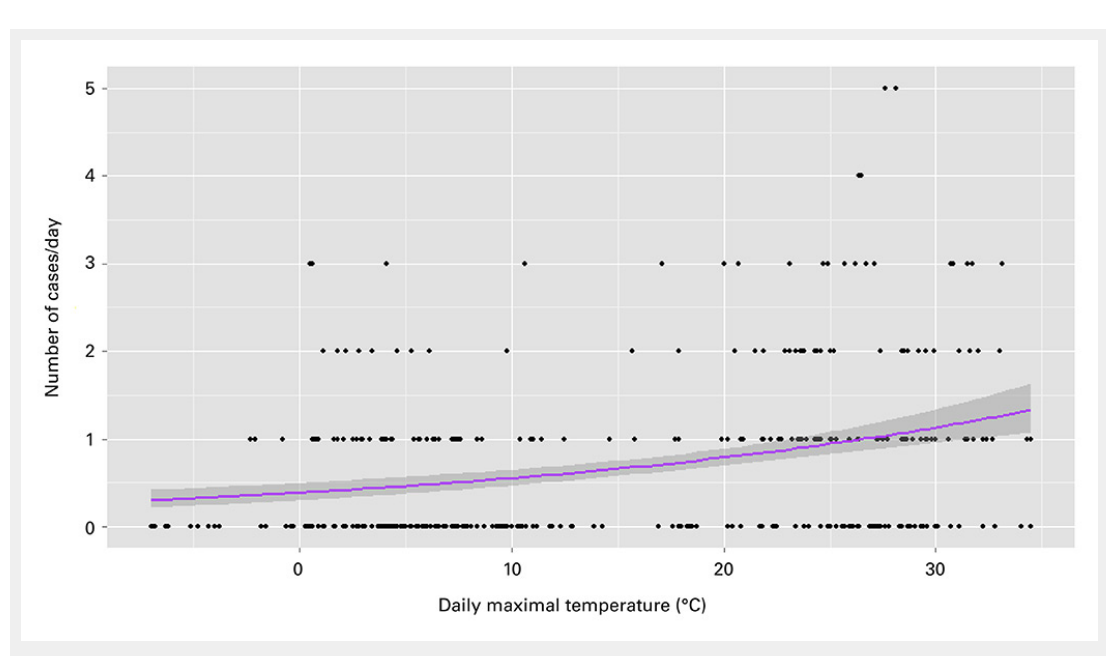
Figure 1 Poisson regression exploring the association between the daily number e of profound hyponatremia cases with maximum daily temperature (°C). Lambda parameter 0.036, p <0.001. Figure was created using R program (the R Foundation for Statistical Computing, Version